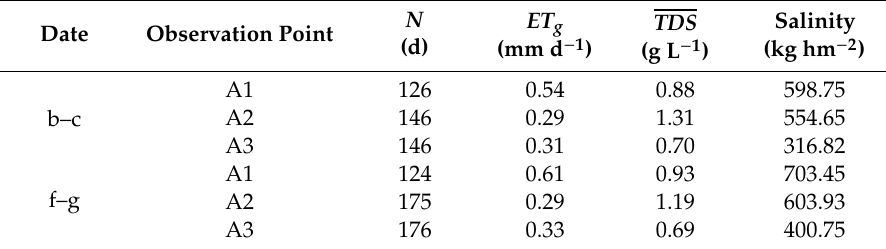
Table 7. Vertical salt transport of groundwater.